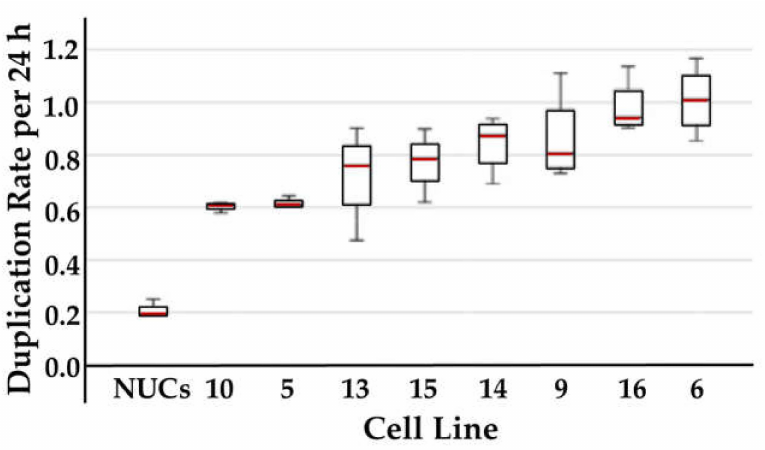
Figure 2. Cell proliferation rates of urothelial cells. Normal urothelial cells (NUCs) and urothelial carcinoma cells (UM-UCs) were seeded in cell culture flasks and duplication rates were counted over 3 consecutive passages. The red lines denote the mean proliferation rates.